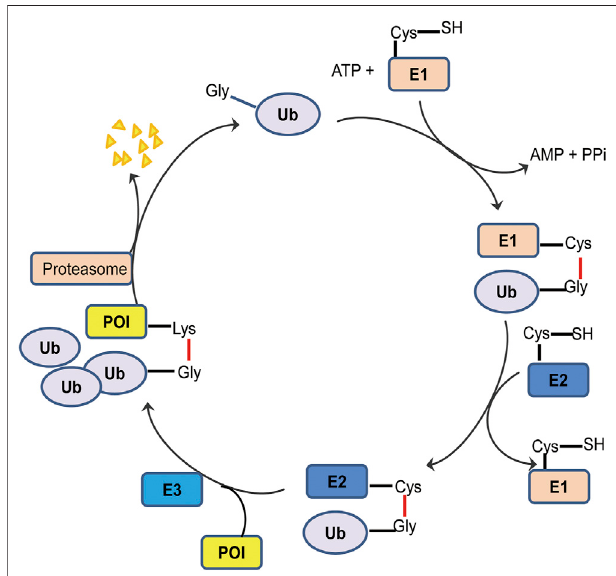
FIGURE 1 | Schematic diagram of ubiquitination process. The ubiquitin tag fi rstbindstoanE1ubiquitinactivating enzyme,transferstoanE2ubiquitin bindingenzyme,and thenrelies onanE3ubiquitinligase todeliveritsubiquitin to the target protein. Ubiquitin labeled proteins are speci fi cally recognized and degraded by